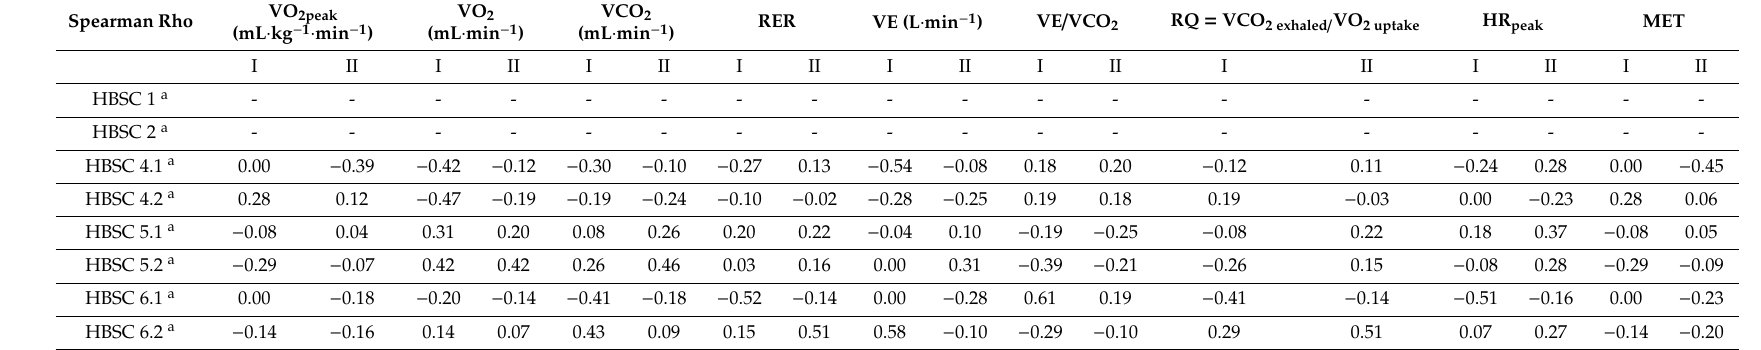
* Results showing the correlation. Group I = children aged 7–10; group II = children aged